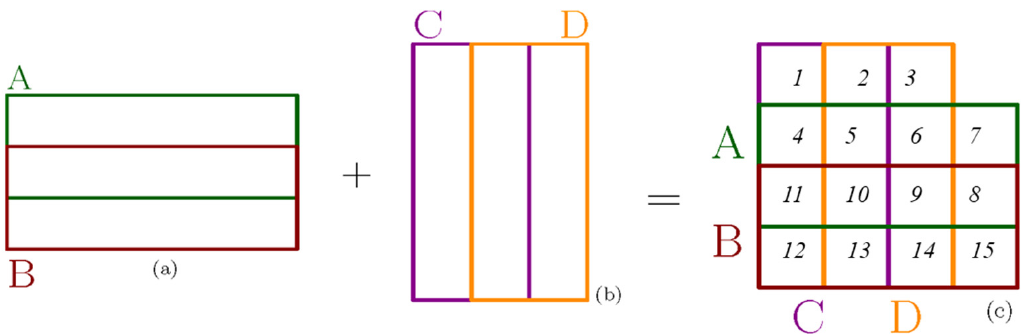
Figure 3. The arrangement for: ( a ) sensor elements A and B partially overlapped horizontally; ( b ) sensors C and D partially overlapped vertically, and ( c ) the final overlapping arrangement of the A/B and C/D sensors.